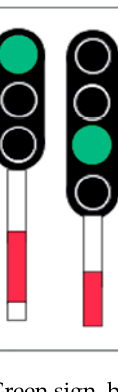
Figure 7. Green sign, both day and night sign; signal on the left: free to pass, expect free to pass or careful; middle and signal on the right: free to pass.